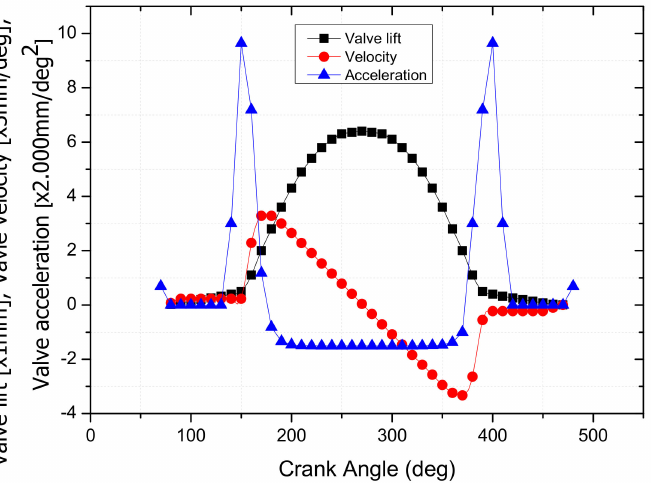
Figure 5. The displacement, velocity, and acceleration curves of the new cam design.